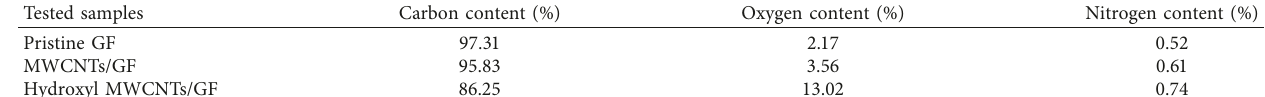
Table 2: Content of C, O, and N elements in hydroxyl MWCNTs/GF, MWCNTs/GF, and pristine GF. Tested samples